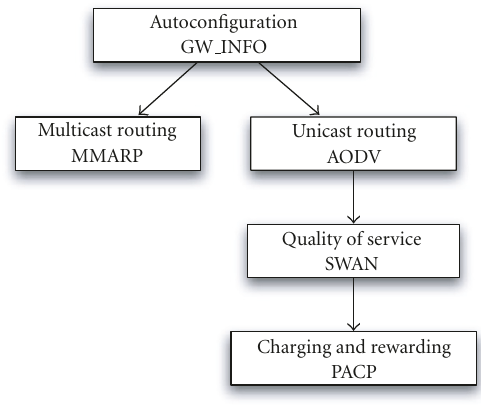
Figure 3: Functional architecture with protocols